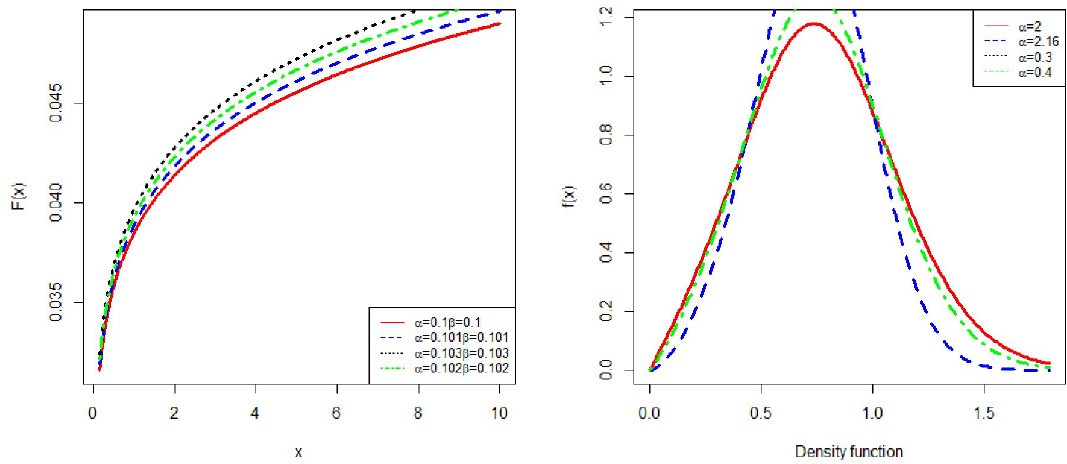
Fig 1. Plots of the CDF and PDF of